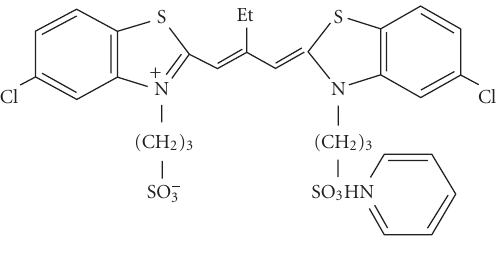
Figure 2: Chemical structure of a typical sensitizing dye used for photographic